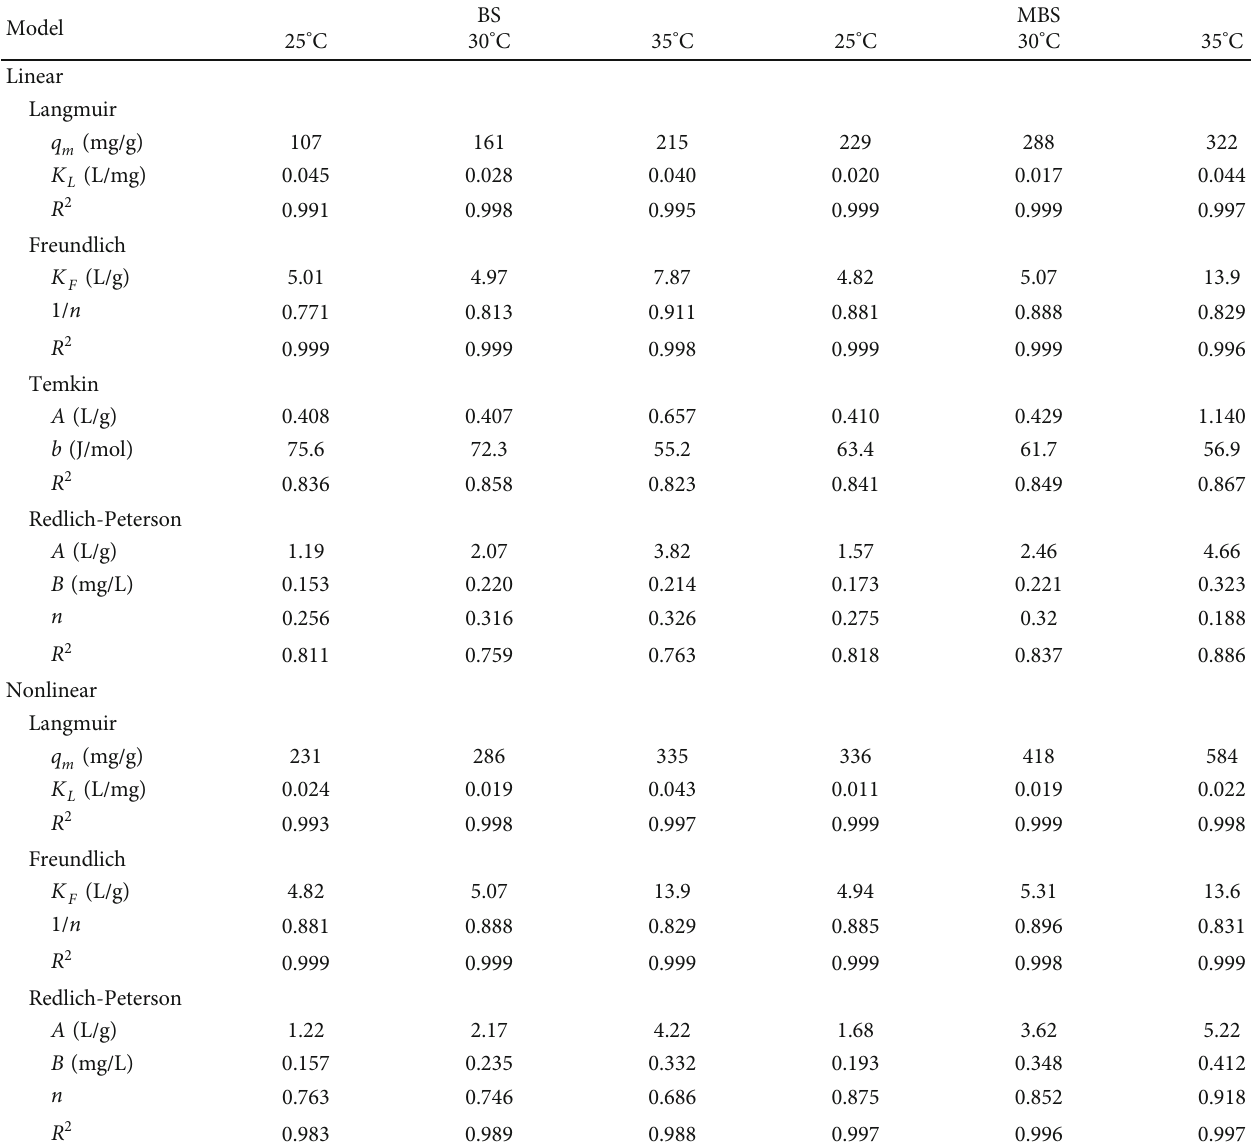
Table 4: Isotherm model parameters of Pb (II) adsorption for various